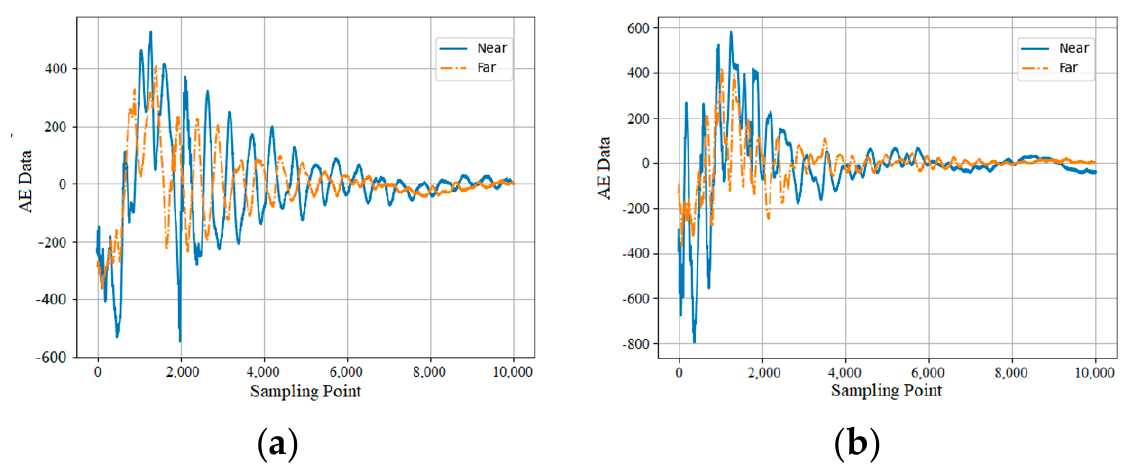
Figure 5. Example of single waveform acquisition results for near-end and far-end AE sensors. ( a ) A typical test waveform of Metasequoia trunk with 10% moisture content; ( b ) a typical test wave-